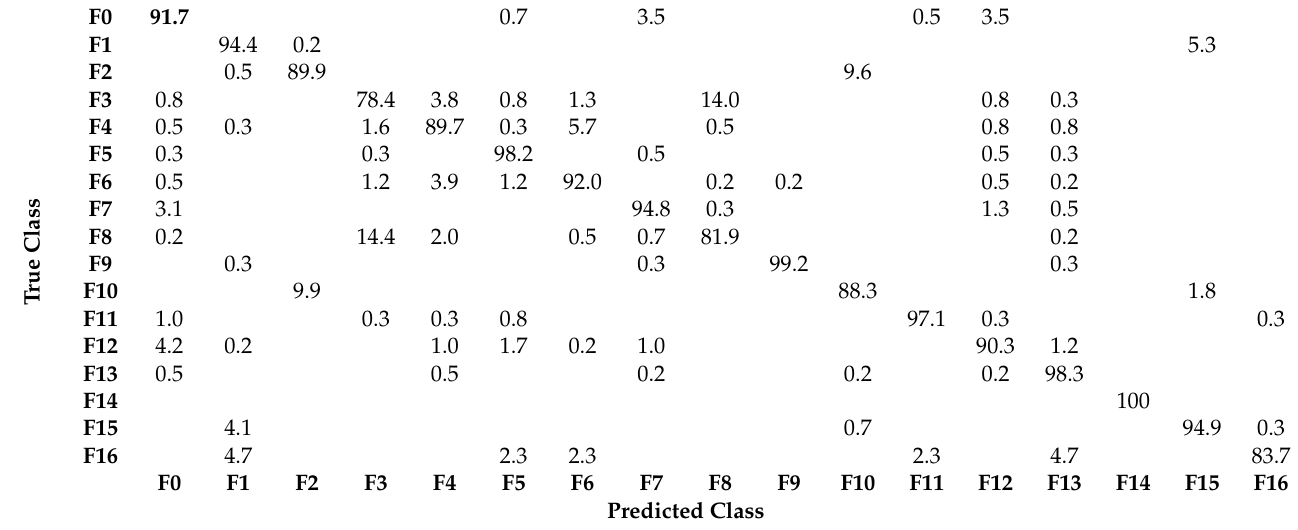
Table 6. Confusion matrix for LWSN for two-switch forward convertor